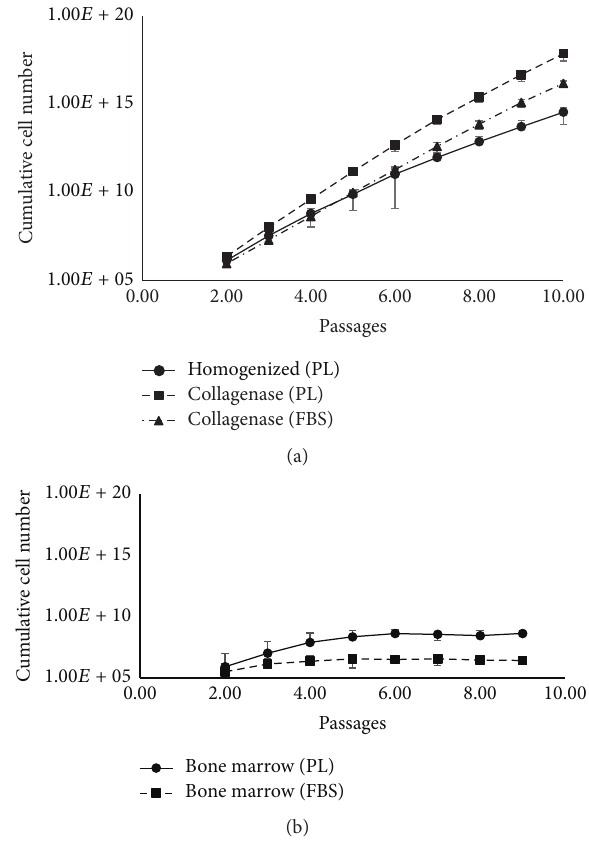
Figure 2: Cultured MSCs demonstrate logarithmic growth poten- tial. Each graph depicts logarithmic growth potential and the theoretical number of cells that can be obtained using different isolation methods and culture conditions over several passages for (a) umbilical cord ( 𝑛 = 8 ), and (b) bone marrow ( 𝑛 = 3 ). Equal numbers of cells were plated for each condition and fold changes were determined after each passage (P2–P10) to determine the theoretical cell number that could be obtained starting with 50,000 cells from P1. Error bars denote mean ±